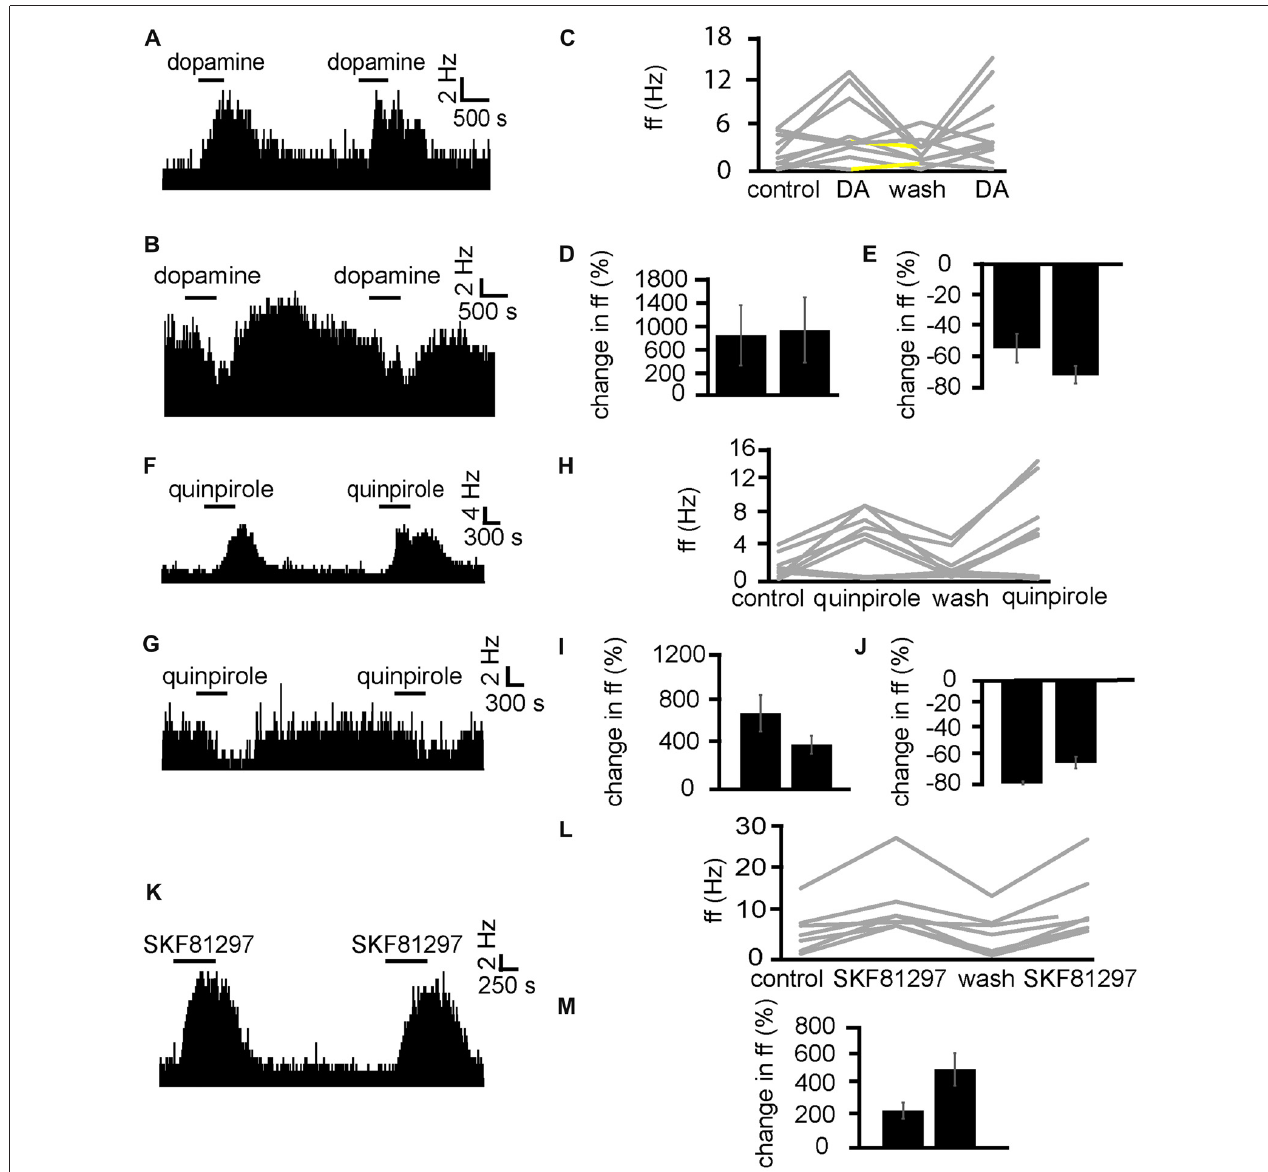
FIGURE 4 | Repeated application of dopamine, D1-like receptor agonists and D2-like receptor agonists produce no clear sensitization effects in VP neurons. (A) Excitatory responses to two similar dopamine applications (separated by complete washout) in a VP neuron. (B) Inhibitory responses to two dopamine applications in a different VP neuron. (C) Changes in firing frequency for 10 VP neurons induced by repeated dopamine applications similar to that illustrated in panels (A,B) . Firing frequency was measured before the first application of dopamine, during the first application of dopamine, after dopamine wash out and finally during the second application of dopamine. Responses characterized by significant ( P < 0.05) changes in firing frequency are in gray, the other ones in yellow. (D) Firing frequency during first and second dopamine application for neurons excited by dopamine. (E) Firing frequency during first and second dopamine application for neurons inhibited by dopamine. (F) Excitatory responses to two quinpirole applications (separated by complete washout) in a VP neuron. (G) Inhibitory response to two quinpirole applications in a different neuron. (H) Changes in firing frequency for nine VP neurons to the repeated application of quinpirole in experiments similar to that illustrated in panels (A,B) . Firing frequency was measured before the first application of quinpirole, during the application of quinpirole, after wash out, before the second application of quinpirole and finally during the second application of quinpirole. Responses characterized by significant ( P < 0.05) changes in firing frequency are in gray, the other ones in yellow. (I) Firing frequency changes during first and second application of quinpirole in neurons excited by quinpirole. (J) Firing frequency changes during first and second application of quinpirole in neurons inhibited by quinpirole application. (K) Excitatory responses to two applications of SKF81297 (separated by complete washout) in a VP neuron. (L) Changes in firing frequency for seven VP neurons in response to repeated SKF81297 application in experiments similar to that illustrated in panel (A) . Firing frequency was measured; before the first application of SKF81297, during the application of SKF81297, after wash out, before the second application of SKF81297 and finally during the second application of SKF81297. Responses characterized by significant ( P < 0.05) changes in firing frequency are in gray, the other ones in yellow. (M) Firing frequency changes during first and second application of SKF81297 for neurons excited by SKF81297 application.